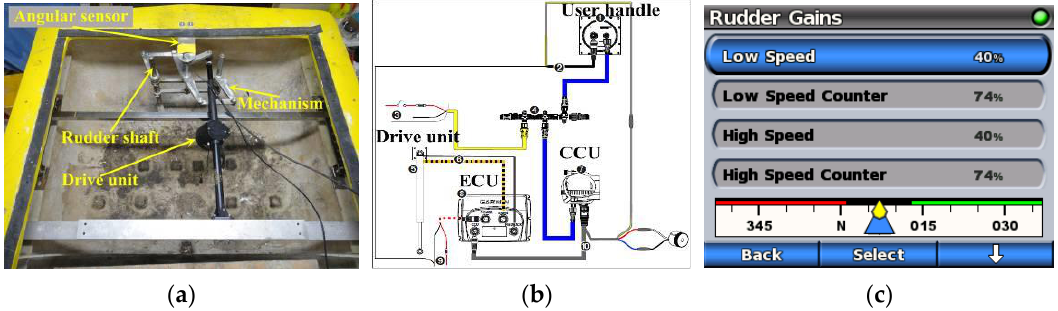
Figure 20. The autopilot system: ( a ) drive mechanism; ( b ) components interconnection; and ( c ) interface of the user control handle.